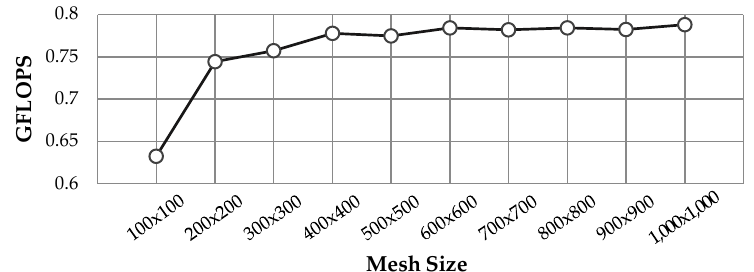
Figure 10. GFLOPS of CUDA_optimized